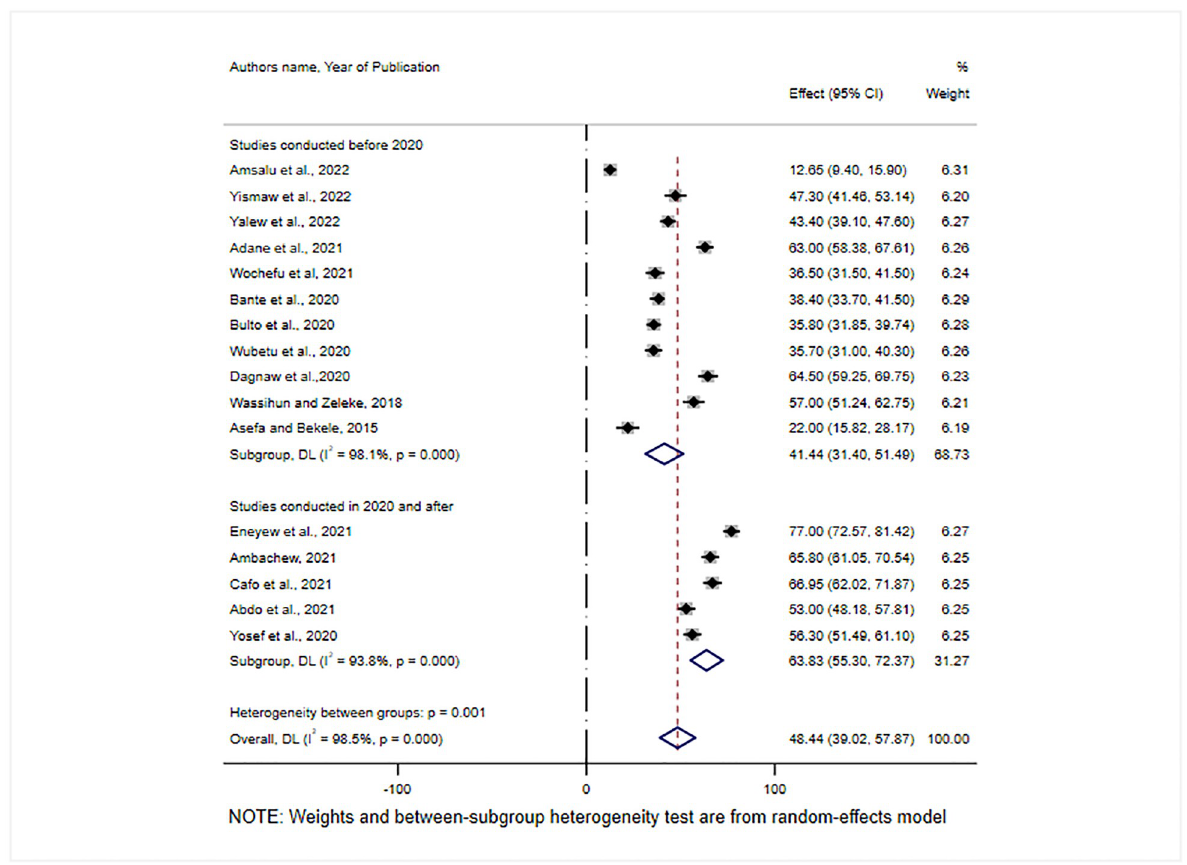
Fig 4. Sub-group analysis for the pooled prevalence of RMC by study year in Ethiopia, 2022.